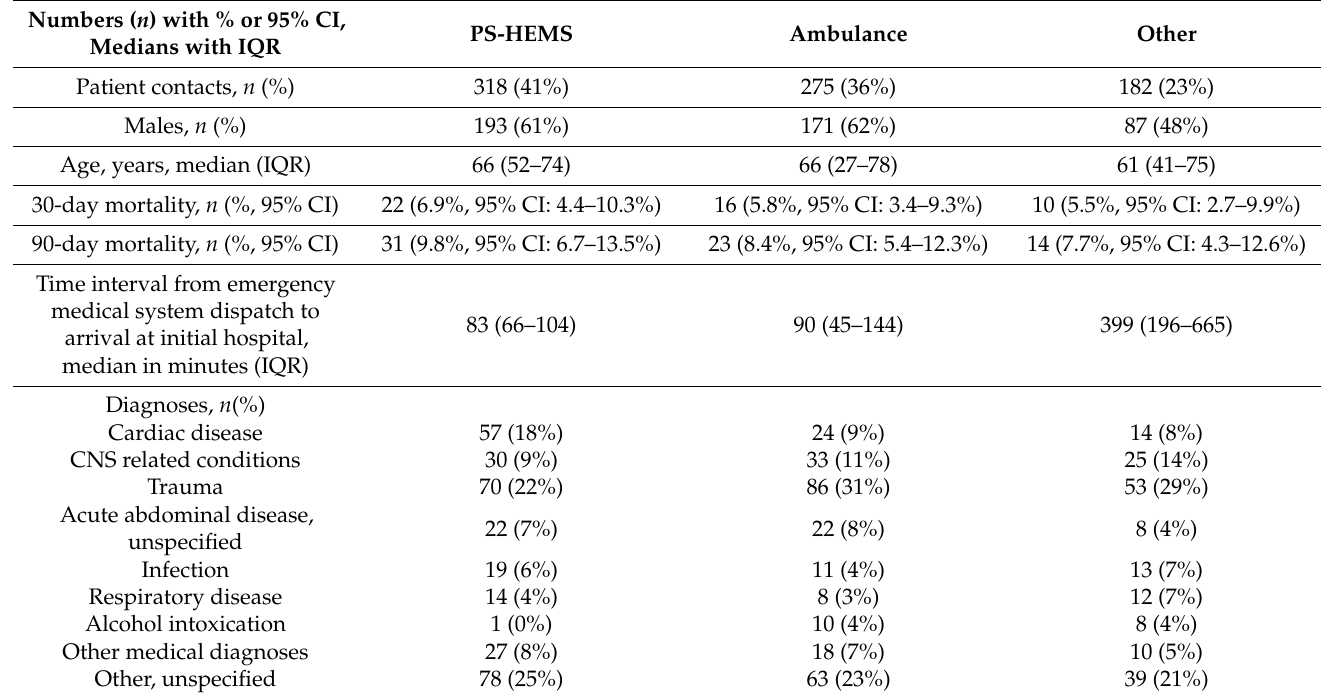
Table 1. Characteristics of patients in need of emergency care from the isolated Danish Islands.